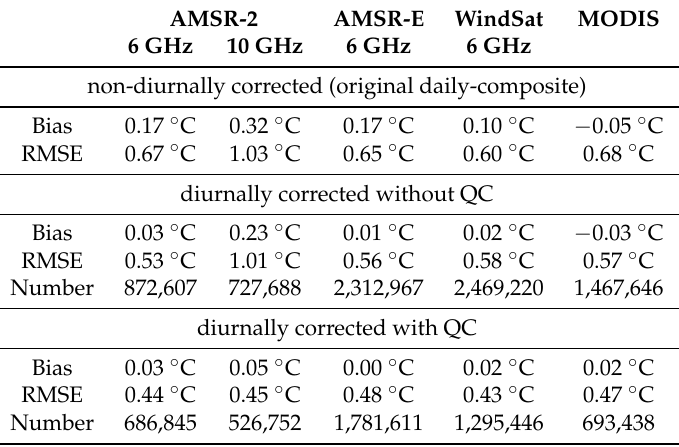
Table 3. Statistics of the validation results of satellite SSTs (non-diurnally corrected, diurnally-corrected with/without QC) against in situ foundation SST measurements by drifting buoys.